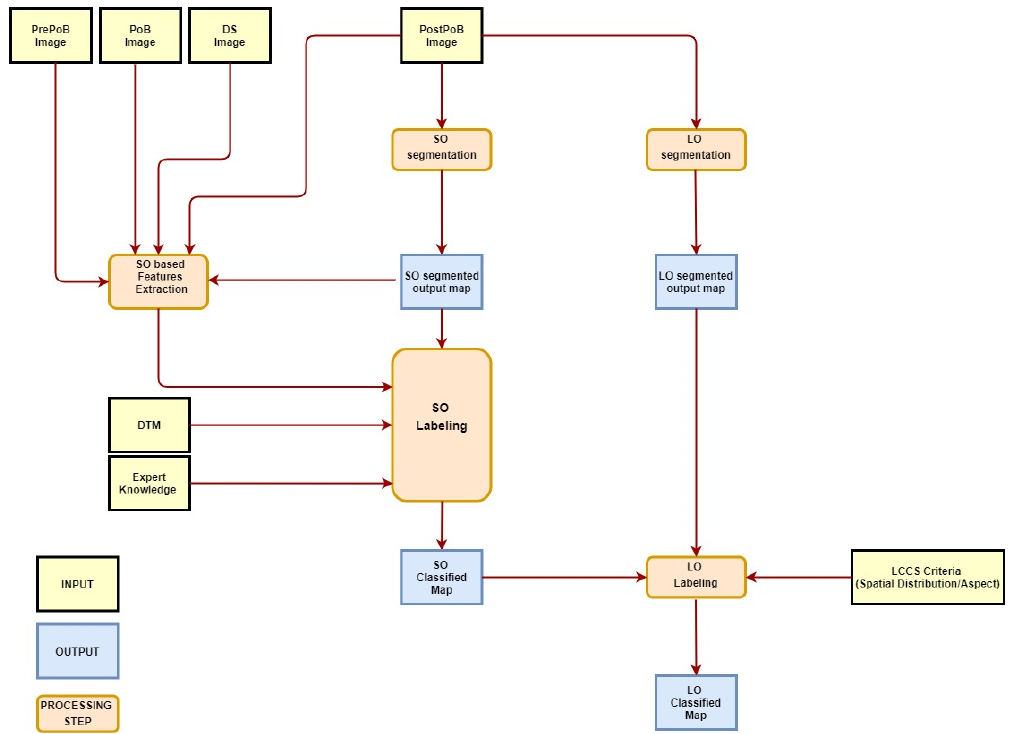
Figure 4. Classification procedure flowchart.